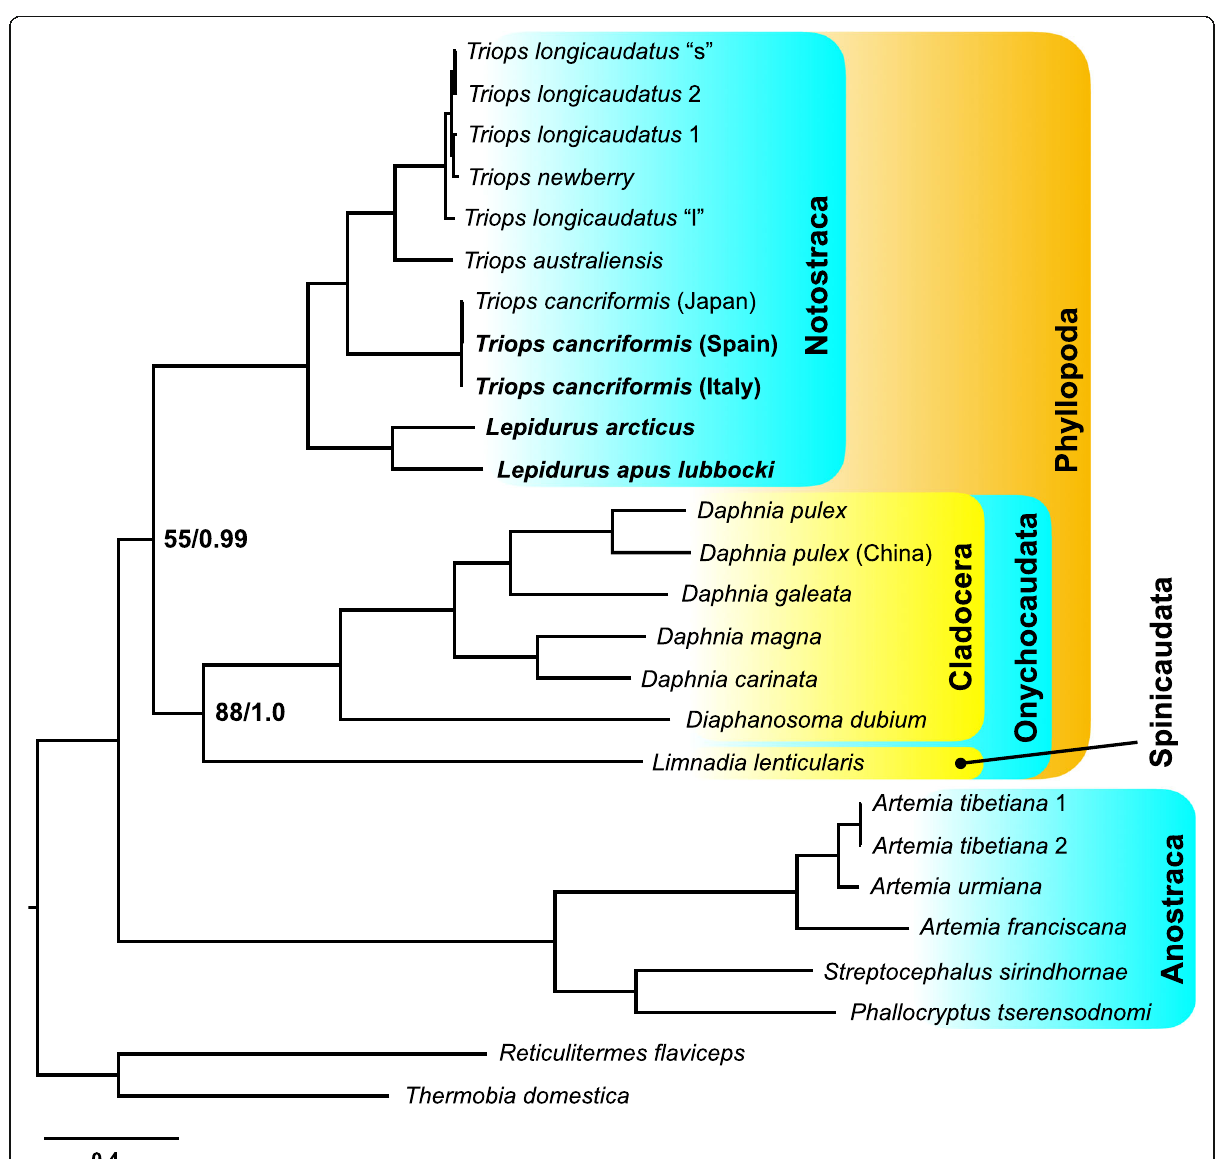
Fig. 4 Schematic drawings of Maximum-likelihood ( − lnL = 196,010.77) and Bayesian inference ( − lnL = 194,237.10) phylogenetic analyses. All